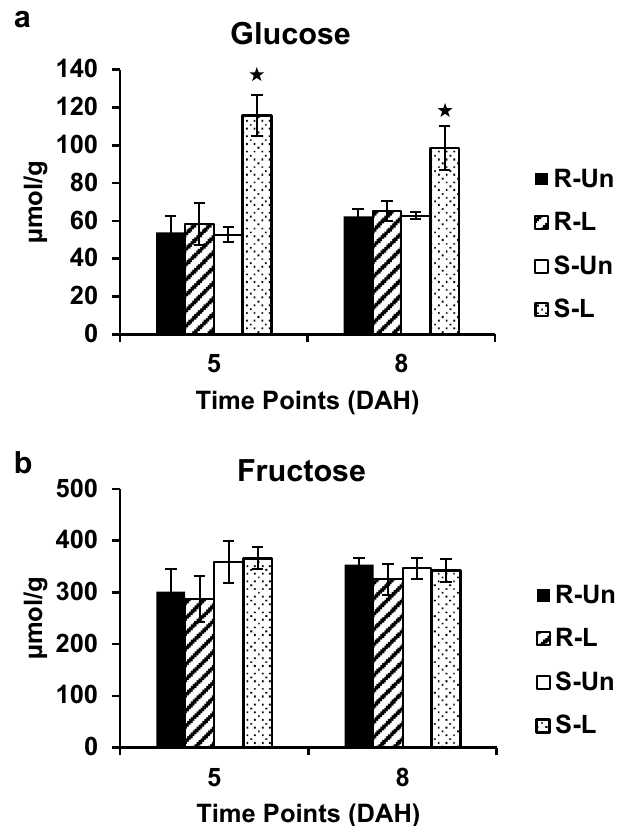
Figure 5. Wheat monosaccharide levels. ( a ) Glucose levels. ( b ) Fructose levels. Levels of monosaccharides, glucose and fructose measured as μmol/g of tissue in Hessian fly-infested resistant Hamlet and susceptible Centurk wheat crown tissue at 5 and 8 DAH. Black solid bar (R-Un) indicates uninfested resistant wheat plants; diagonal bar (R-L) indicates resistant wheat plants infested with Biotype L, white bar (S-Un) indicates uninfested susceptible wheat plants; dotted bar (S–L) indicates susceptible wheat plants infested with Biotype L. Error bars represent mean ± SE of three independent biological replicates ( n = 3). Statistically significant ( p < 0.05) differences in monosaccharide levels between infested and uninfested (control) wheat plants are indicated by